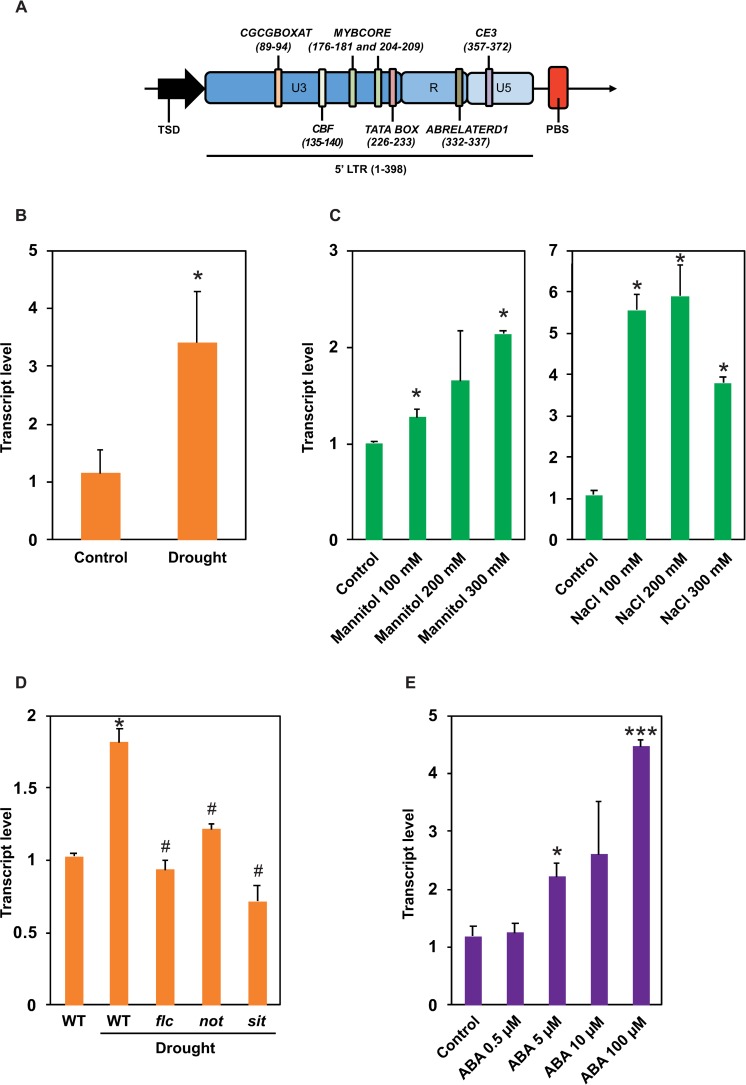
Rider activation is stimulated by drought and ABA.(A) Identification of cis-regulatory elements (CREs) within Rider LTRs. Rider LTR U3, R and U5 regions are marked, as well as neighbouring Target Site Duplication (TSD) and Primer Binding Site (PBS) sequences. CREs are marked as coloured vertical bars; their bp positions are given in brackets. (B-C) Quantification of Rider RNA levels by RT-qPCR in tomato seedlings after (B) drought stress or (C) mannitol and NaCl treatments. Bar charts show normalized expression relative to Control, +/- SEM from two to three biological replicates. *P<0.05, two-sided Student’s t-test. (D) Quantification of Rider RNA levels by RT-qPCR in leaves of drought-stressed tomato wild-type plants, flc, not and sit mutants. Bar charts show normalized expression relative to WT Control, +/- SEM from two to three biological replicates. *P<0.05 denotes difference compared to wild-type control; #
P<0.05 denotes difference compared to wild-type drought plants, two-sided Student’s t-test. (E) Quantification of Rider RNA levels by RT-qPCR in tomato seedlings after ABA treatment. Bar charts show normalized expression relative to Control, +/- SEM from two to three biological replicates. *P<0.05, ***P<0.001, two-sided Student’s t-test.